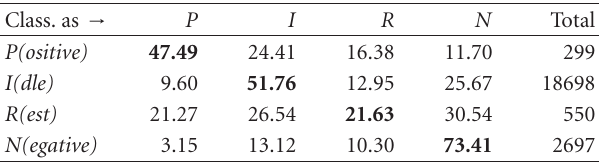
Table 9: Confusion matrix, acoustics + linguistics, word evaluation in percent correct.